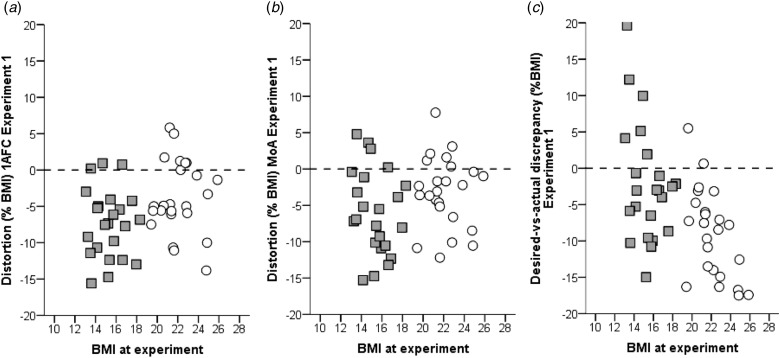
Distortion as measured by the One-Alternative-Forced-Choice task
(a) and the Method-of-Adjustment task (b) and
Desired-v.-actual Discrepancy (c) in percent of
participants’ actual weight in Experiment 1 (own photo-realistic texture) depending
on personal BMI of the participants. Gray squares: Women with AN. White circles:
Controls. The dashed horizontal line indicates hypothetical accurate performance/no
desire for weight change. Positive values reflect overestimation/ a higher desired
than actual body weight, negative values reflect underestimation/a lower desired
than actual weight.